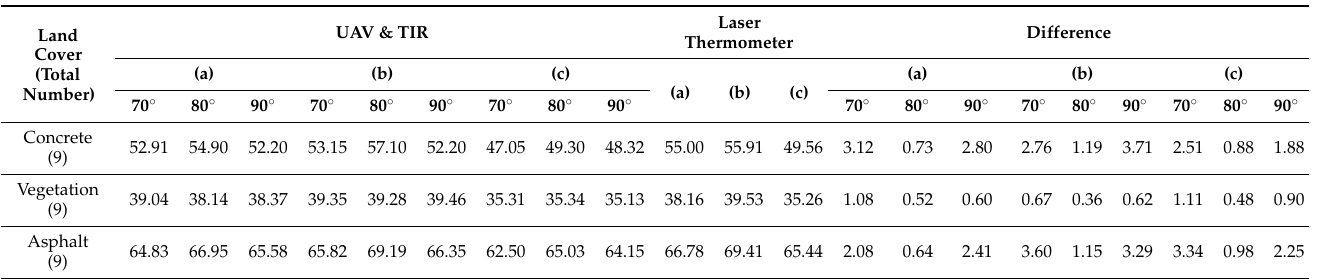
Table 4. Average LST difference of site A by land cover (unit: ◦ C): ( a ) 28 July 2021, ( b ) 4 August 2021, ( c ) 16 August 2021.